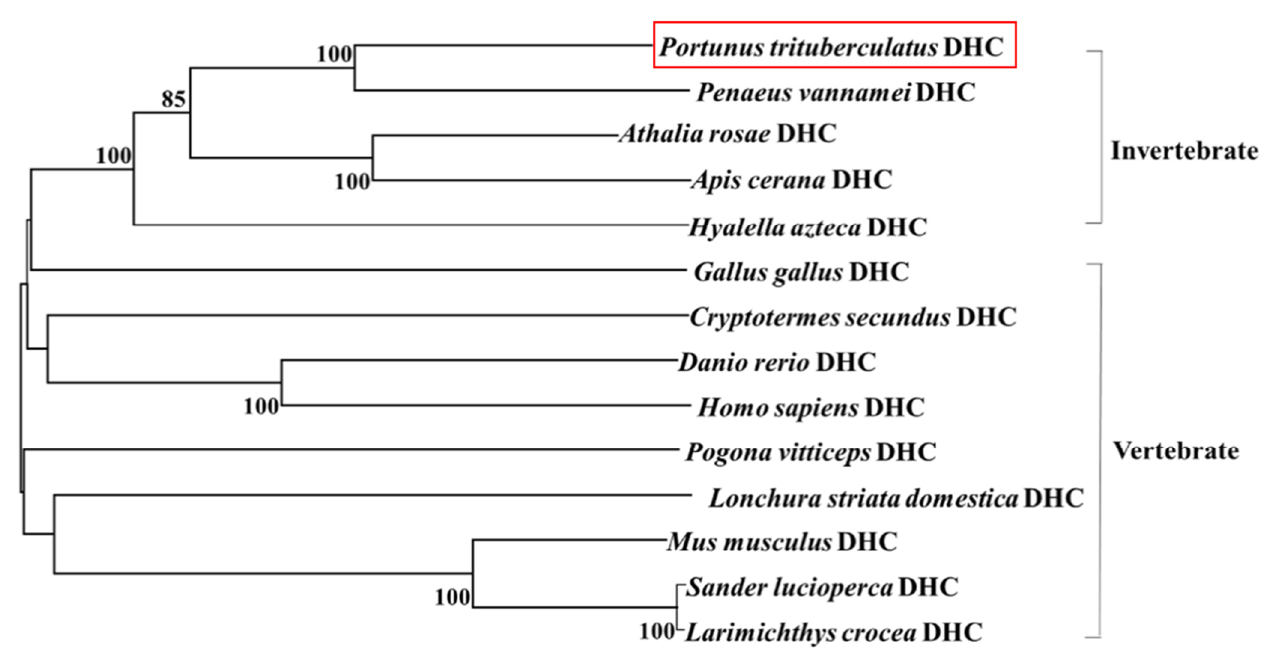
Figure 2. Phylogenetic tree based on DHC protein sequences. The phylogenetic tree was generated based on the alignment of proteins sequences using MEGA 5.0 software using neighbor-joining method.